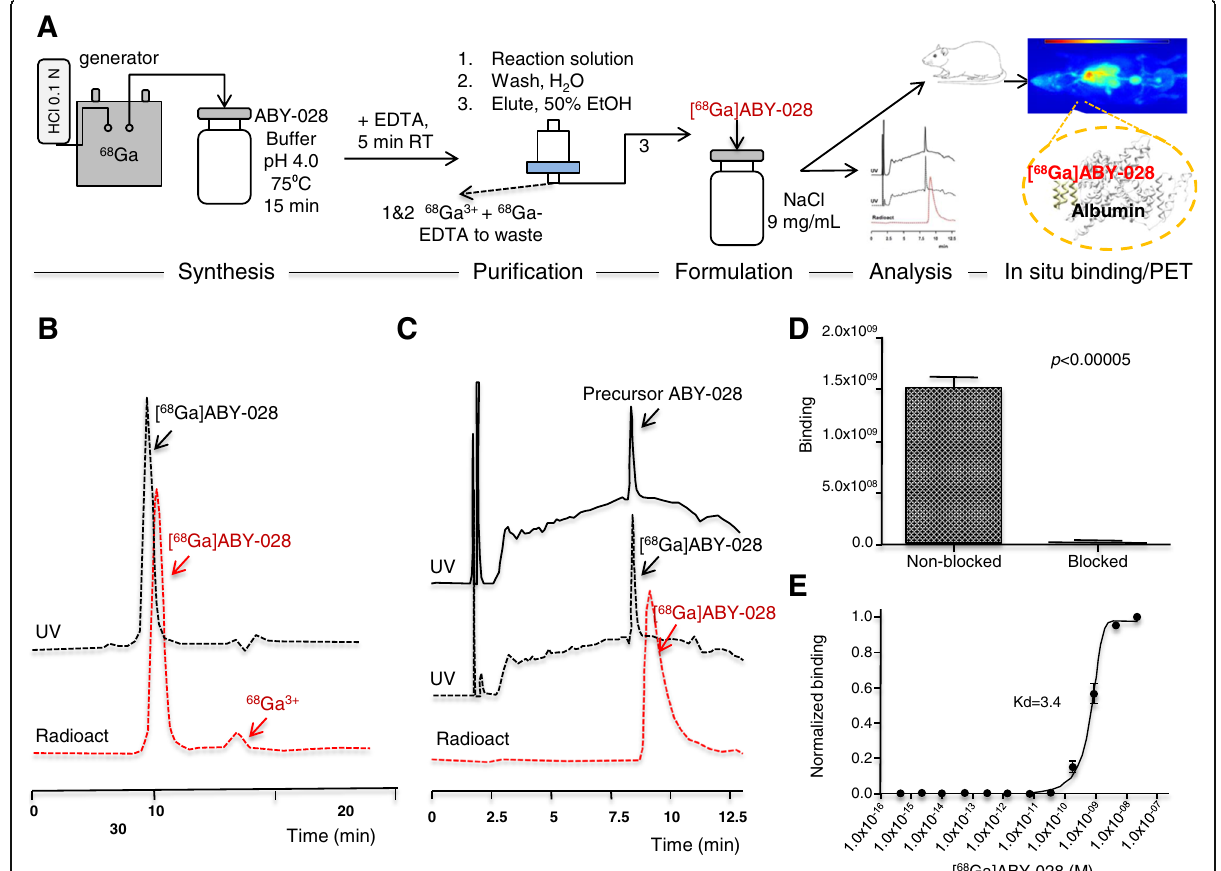
Fig. 2 Radiolabeling and analyses of [ 68 Ga]ABY-028. a The major steps in the radiolabeling with 68 Ga. b Size-exclusion chromatography of the reaction solution after the labeling of [ 68 Ga]ABY-028 (UV and radio). c Reversed phase chromatography of reference precursor ABY-028 (UV) compared with the purified [ 68 Ga]ABY-028 (UV and radio). d Analysis of [ 68 Ga]ABY-028 binding to immobilized HSA with and without blocking using a 200-fold excess of non-labeled ABY-028. e Analysis of [ 68 Ga]ABY-028 binding to immobilized HSA. The normalized radioactivity is plotted against the concentration of [ 68